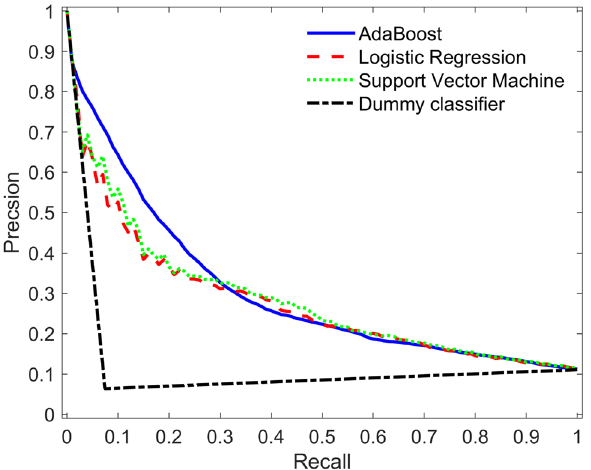
Figure 1. The average Precision-Recall curves for all classifiers with respect to a dummy classifier. The area under the curve (AUC) reported as mean (standard deviation): Adaptive boosting (AdaBoost) – 0.30 (0.07), support vector machine – 0.29 (0.05), and logistic regression – 0.28